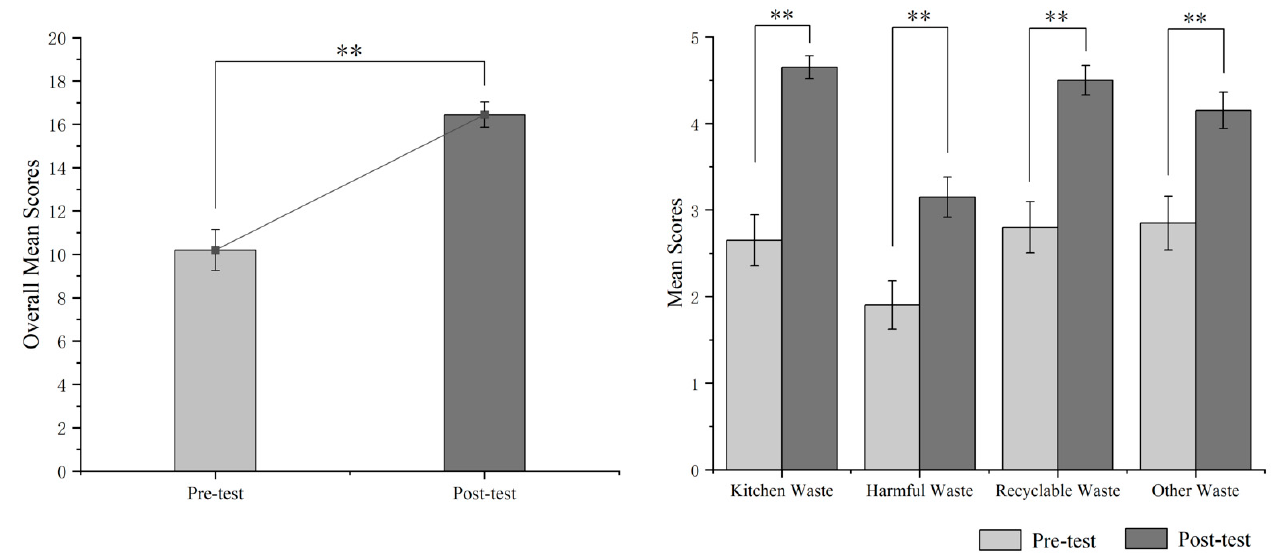
Figure 6. Comparison of delivery accuracy between pre-test and post-test. ** p <